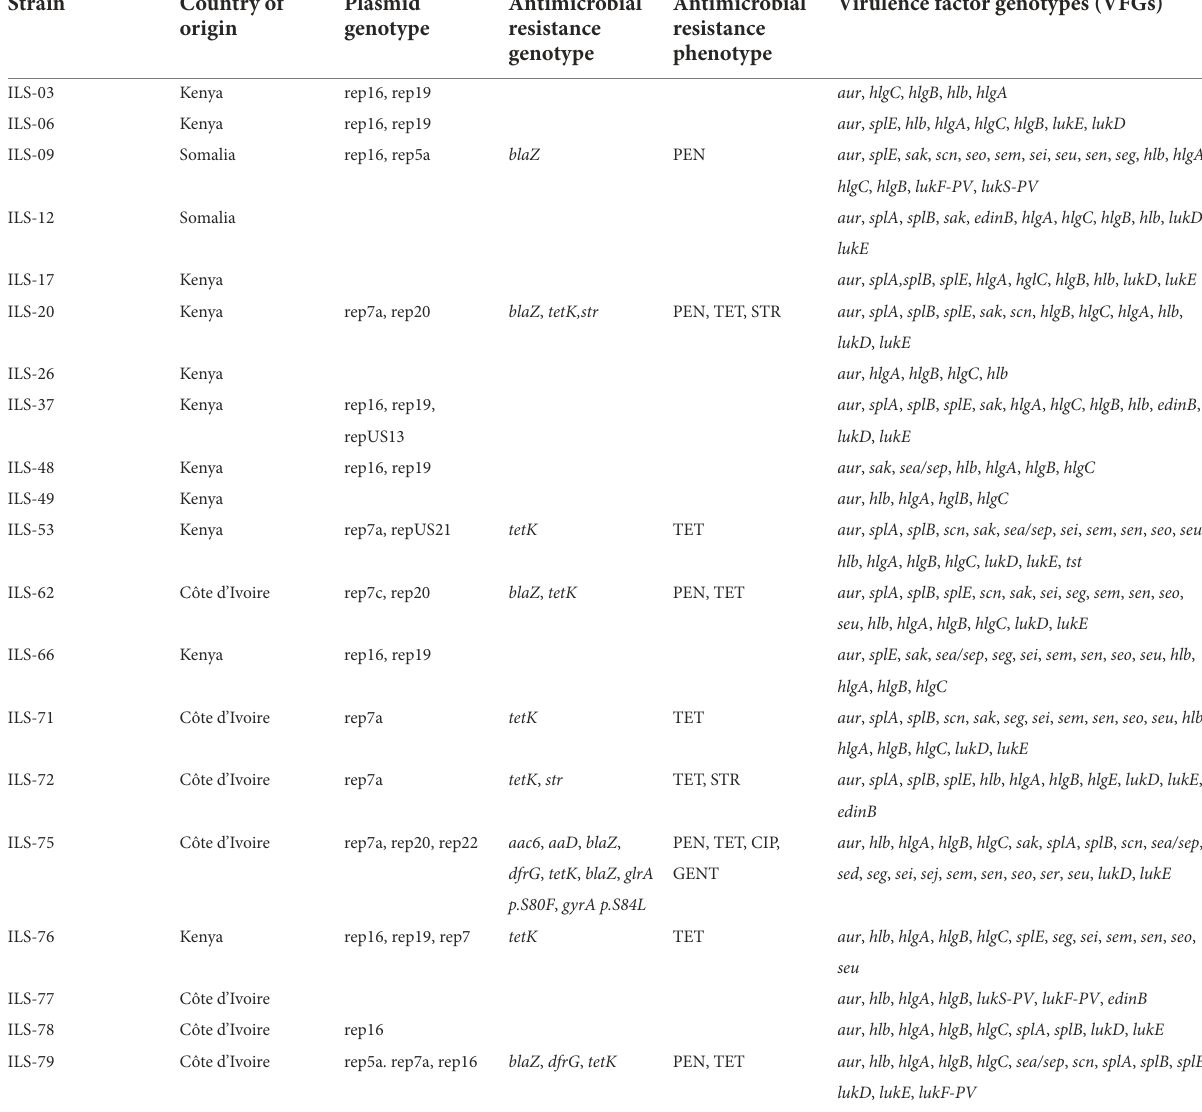
TABLE 4 ILS S. aureus strains and their genotype and phenotype details on plasmids, antimicrobial resistance, and virulence